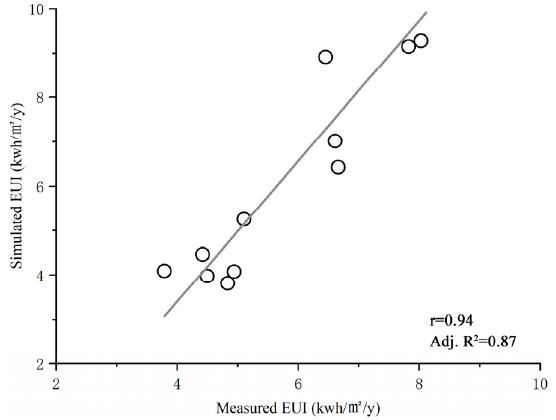
Figure 11. Results of linear regression analysis.